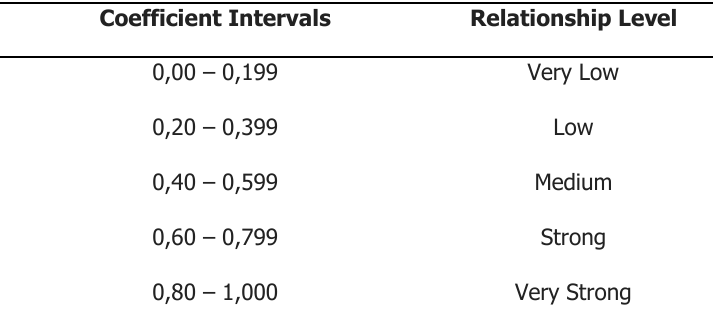
Table 1 . Guidelines for Interpretation of Correlation Coefficients